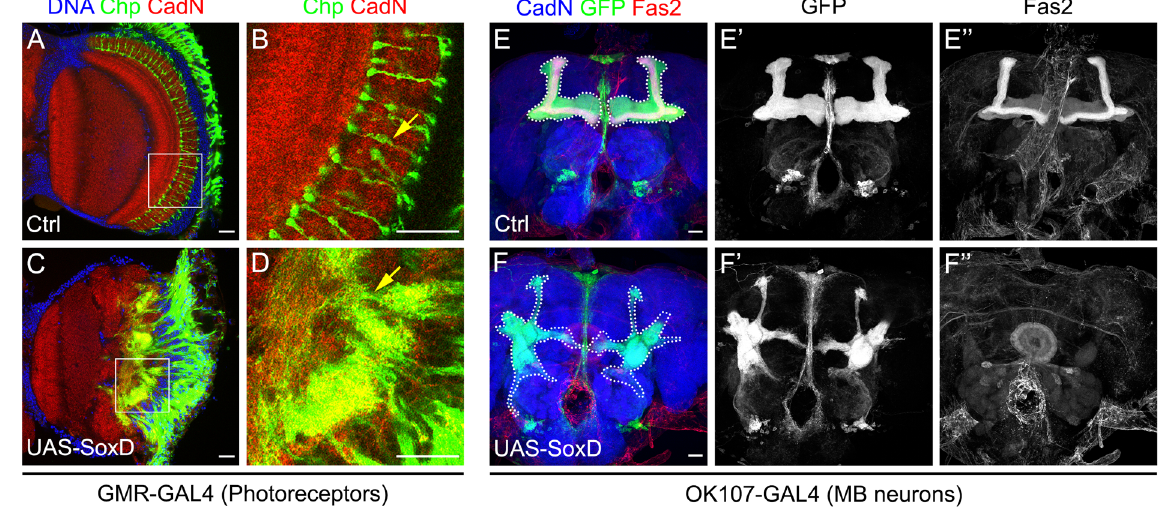
Figure 7. SoxD misexpression disrupts neurite guidance. ( A–D ) Immunofluorescence of adult optic lobes of GMR-GAL4 ( A , B ) control and ( C , D ) UAS-SoxD, stained for Chp (green), CadN (red) and DNA (blue). Arrows point to photoreceptors in the medulla. ( E,F ’) Immunofluorescence of adult central brain of OK107-GAL4, UAS-mCD8-GFP ( E,E” ) control and ( F,F” ) UAS-SoxD, stained for GFP (green or gray), Fas2 (red or gray) and CadN (blue). The structure of the mushroom body is highlighted by dotted lines. Scale bars are 20 µ